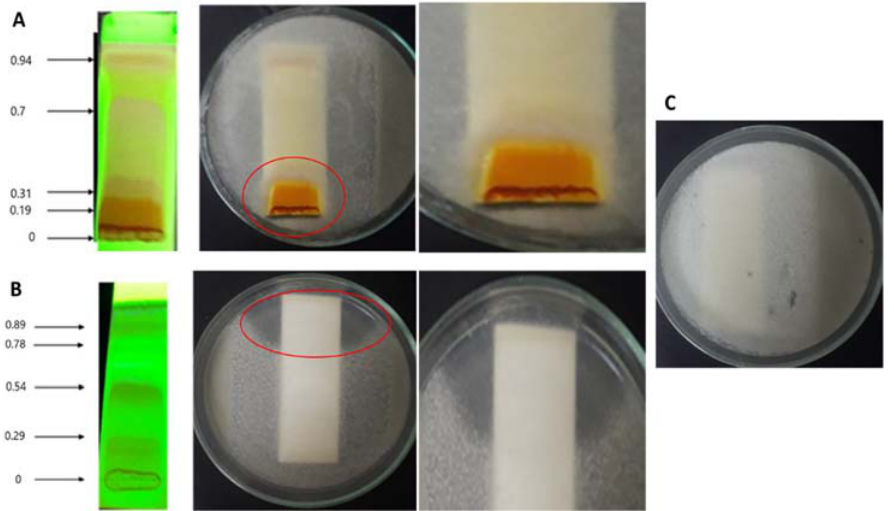
Figure 5. Bioautography assay for the extracts. ( A ) Chromatogram of the extract obtained from Bl1 visualized using UV light (254 nm) (mobile phase CHCl 3 :MeOH 9:1) ( left ). Bioautography of the extract Bl1 ( center ). Zone of inhibition ( right ). ( B ) Chromatogram of the extract obtained from Ech4 visualized using UV light (254 nm) ( left ) (mobile phase CHCl 3 :MeOH 9:1). Bioautography of the extract Ech4 ( center ). Zone of inhibition ( right ) Red circle indicates zone of inhibition. ( C ) Solvent control (mobile phase CHCl 3 :MeOH 9:1).